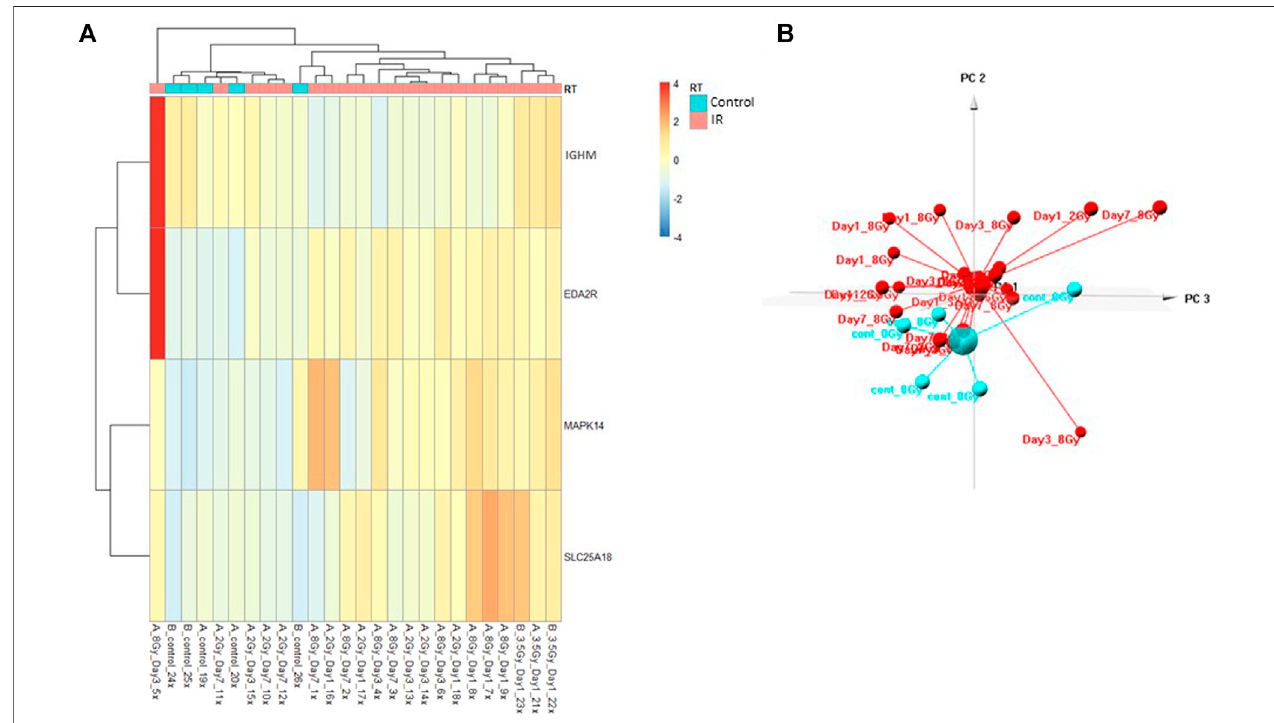
FIGURE 2 | Control vs. RT Test Model. Analysis of proteomic expression within the sample cohort used for testing of the Control vs. RT Test model using top selected proteins IGHM, MAPK14, EDA2R, and SKC25A18. Findings are represented by (A) heatmap and (B) PCA.